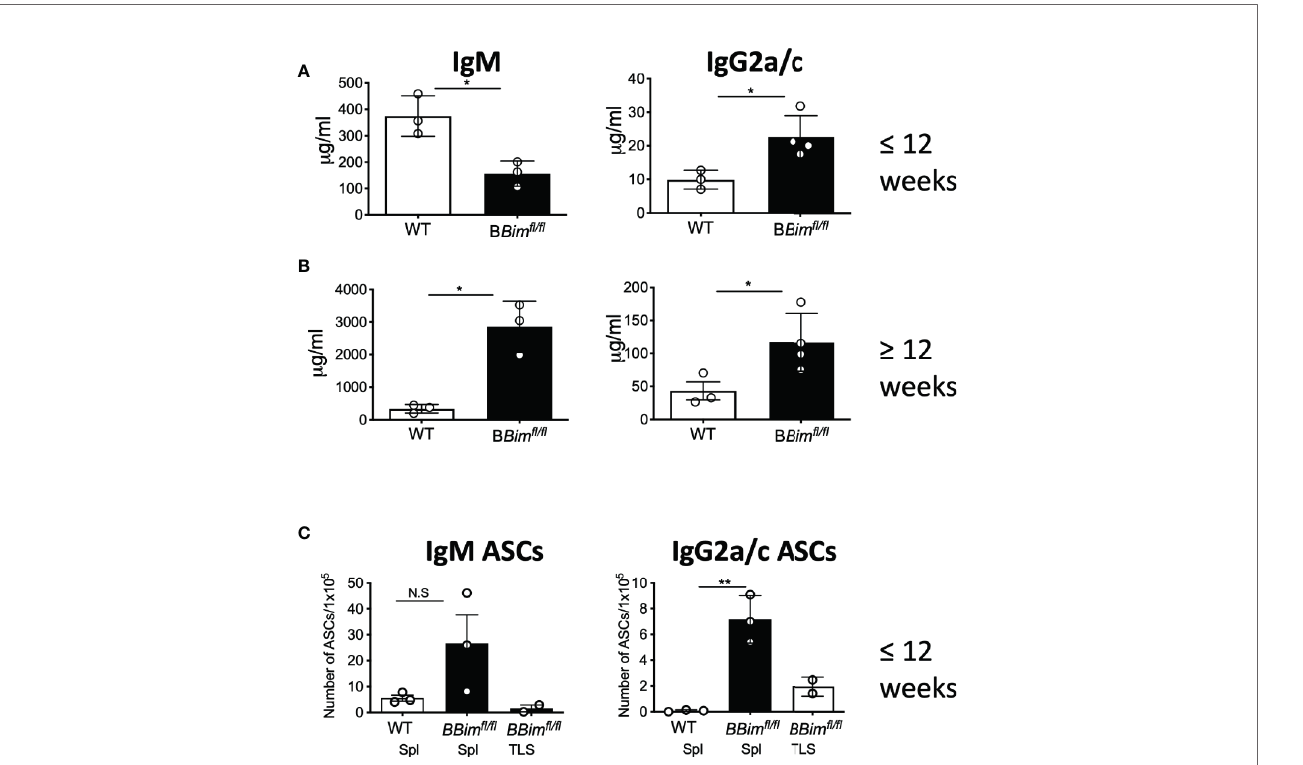
FIGURE 5 | BBim fl / fl mice exhibit hypergammaglobulinemia and increased ASCs. Quanti fi cation of serum immunoglobulins and ASCs in WT and BBim fl / fl mice. (A) IgM and IgG2a/c levels in serum from mice ≤ 12 weeks old (B) IgM and IgG2a/c levels in mice ≥ 12 weeks old mice. Numbers of (C) IgM and IgG2a/c ASCs in splenocytes in mice ≥ 12 weeks old. Data is representative of >3 independent experiments. Not signi fi cant (N.S) P > 0.05, *P ≤ 0.05, **P ≤ 0.01, calculated by Students